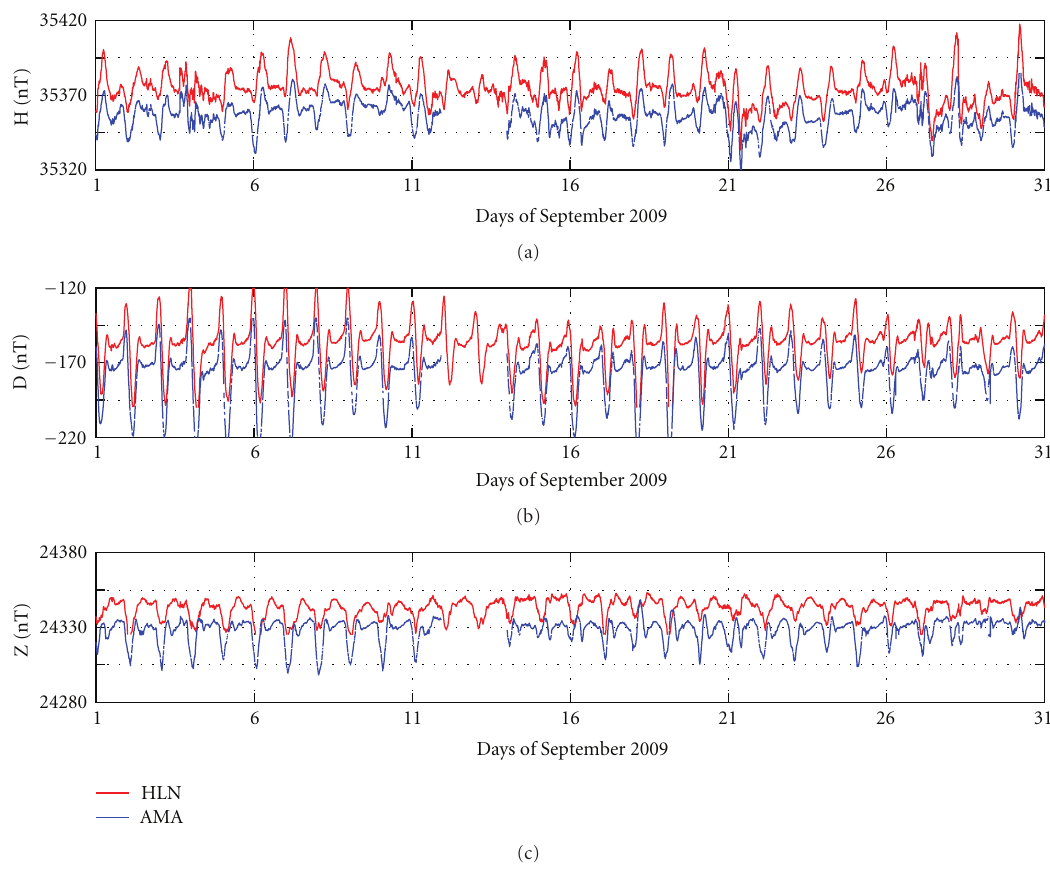
Figure 3: One-minute average values of the H (a), D (b), and Z (c) components recorded at the HLN (red curves) and AMA (blue curves) stations in September